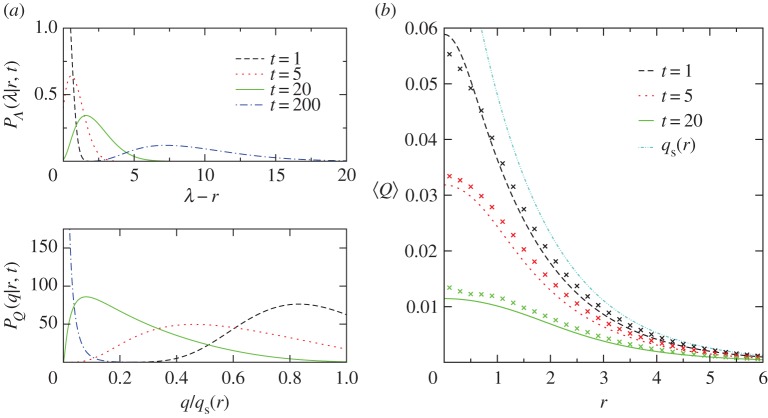
Moisture distribution for the initial-value problem. (a) Theoretical PDFs for the maximum excursion Λ and the specific humidity Q of a parcel at r=π/2 and different times t. To ensure convergence in the tails, these PDFs are calculated from (3.18) and (3.19) by including the first 50 terms of the series. The same parameter values as those in the Monte Carlo simulation of figure 1 are used in the formulae. (b) Profile of the ensemble mean specific humidity 〈Q〉 at different times t. The curves are theoretical predictions calculated using (3.20) and the first 10 terms in expression (3.19) for PQ(q|r,t). The crosses are the results from Monte Carlo simulations. The saturation specific humidity profile qs(r) is also shown. (Online version in colour.)